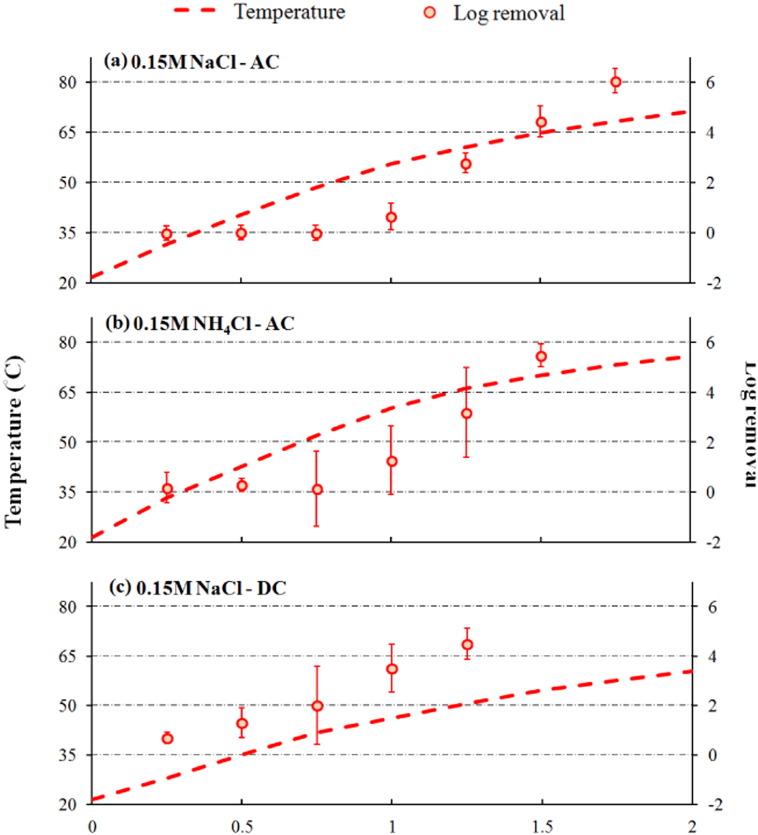
Temperature and removal of E. coli over treatment time.